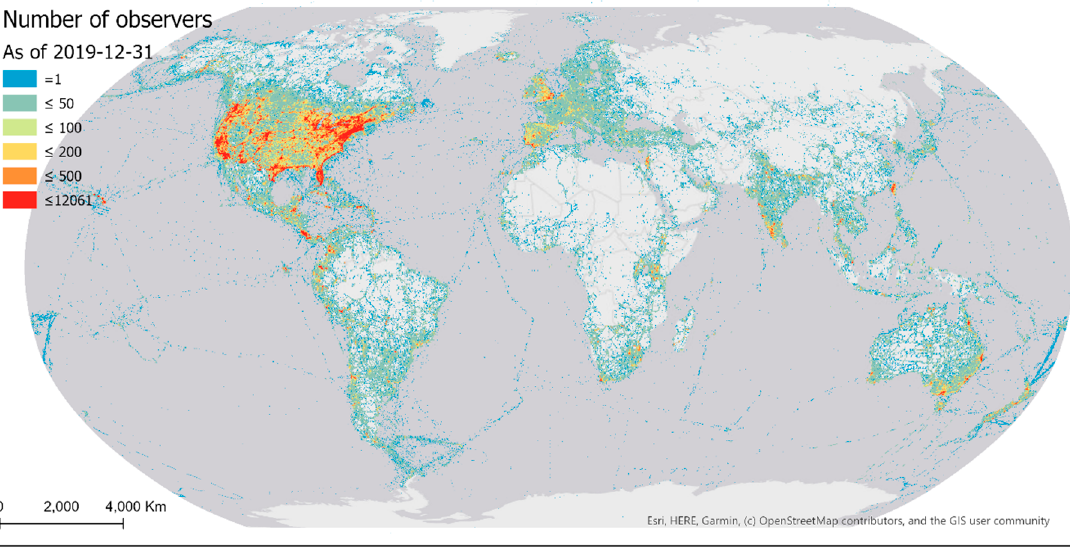
Figure 9. The cumulative number of observers as of 31 December 2019 mapped over 0.25° latitude × 0.25° longitude grid cells. Intervals were determined loosely following quartile classification method.